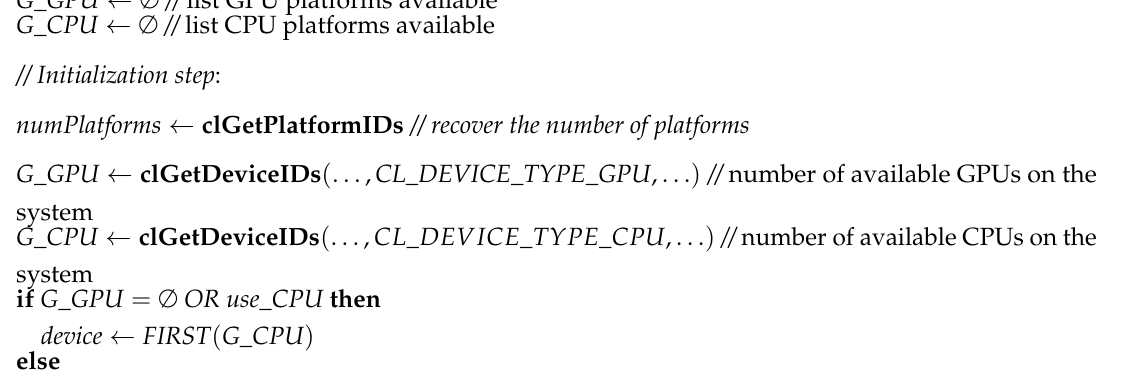
Algorithm 2 NLM_OPENCL( Ω , ˜ Ω , σ 2 , use _ adp _ σ = false , δ , N x , N y , d , v , use _ CPU